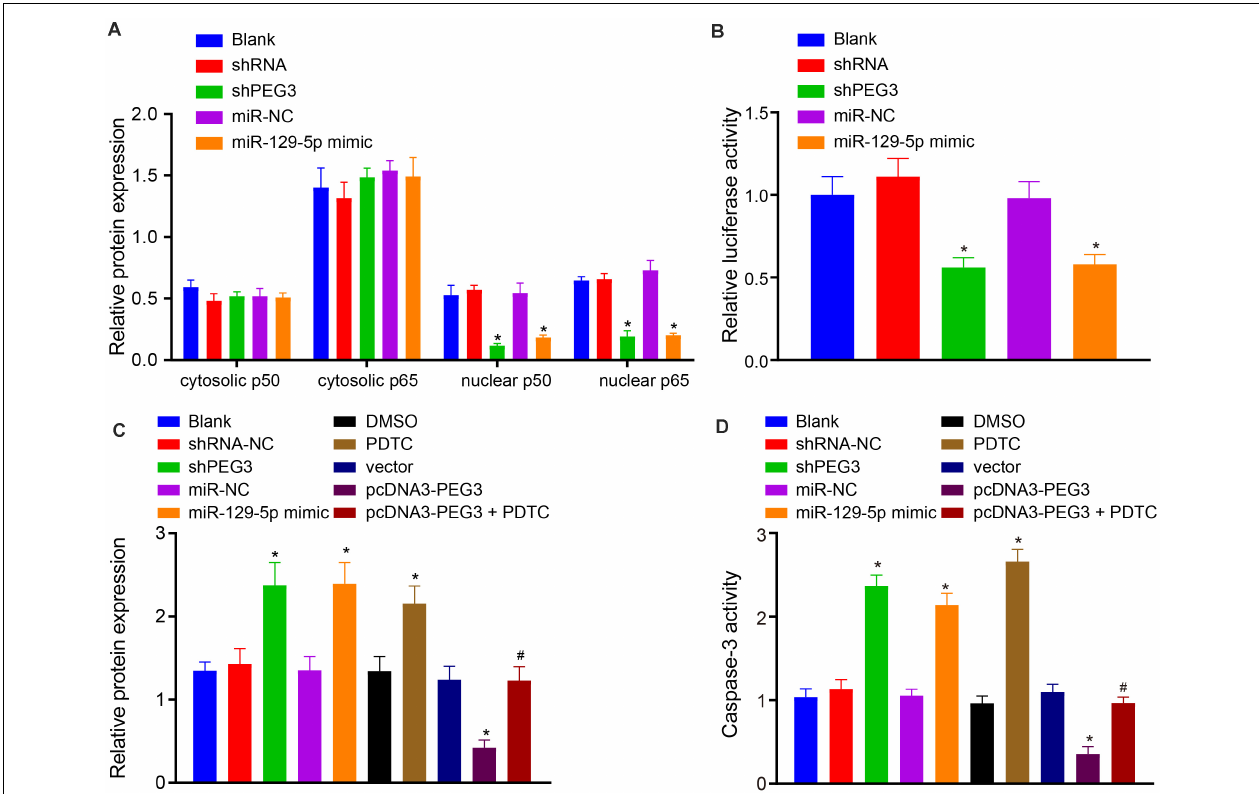
FIGURE 8 | Restoration of miR-129-5p or silencing PEG3 promotes HSC apoptosis through the NF- κ B signaling pathway. (A) Relative protein levels of p50 and p60 in the nucleus and cytoplasm normalized to GAPDH determined by western blot analysis. (B) Relative luciferase activity of NF- κ B signaling pathway reporter. (C) Relative expression of cleaved PARP normalized to GAPDH determined by western blot analysis. (D) Caspase-3 activity. * p < 0.05 vs. the blank, miR-NC, DMSO, or vector group (HSCs without any treatment or in the presence of miR-NC, DMSO, or vector). # p < 0.05 vs. the pcDNA3-PEG3 group (HSCs in the presence of pcDNA3-PEG3). All data were measurement data and expressed as mean ± standard deviation. One-way analysis of variance was used for data comparison among multiple groups. The experiment was independently repeated three times. N = 6. PARP, poly ADP-ribose polymerase; DMSO, dimethyl